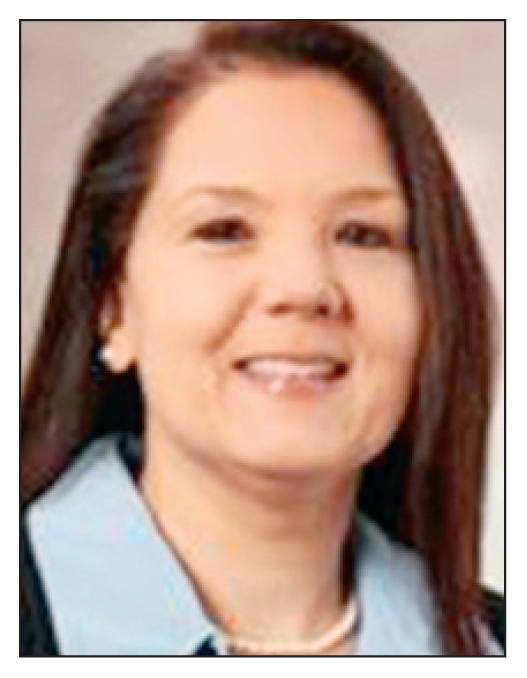
Adrienne Ettinger